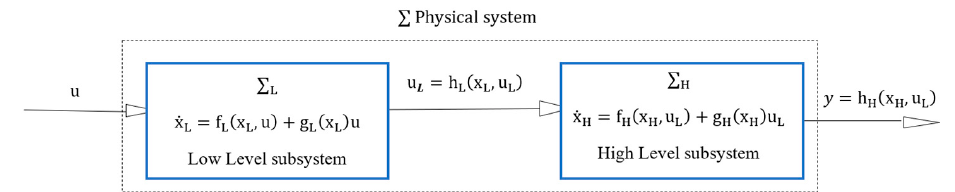
Figure 1. The structure of an interconnected system.